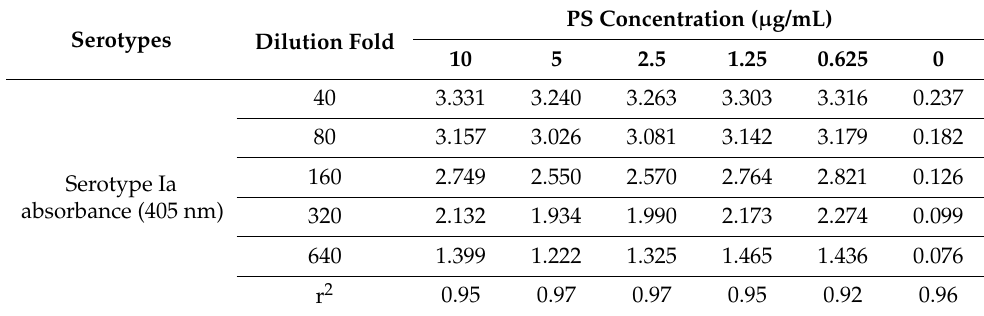
Figure 3. Inhibition group B Streptococcus (GBS)-enzyme-linked immunosorbent assay (ELISA) using homologous or heterologous GBS polysaccharide (PS). To confirm specificity of PS-ELISA,